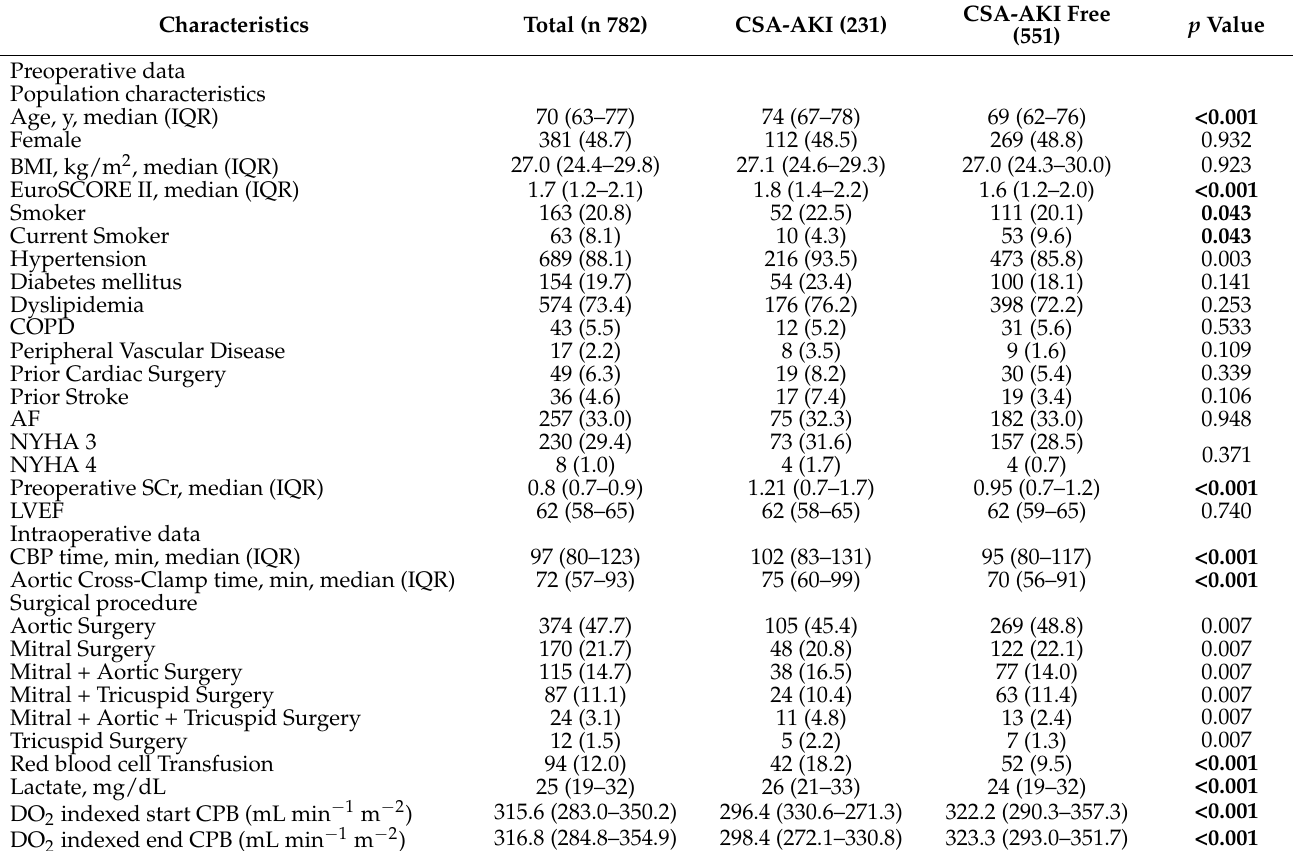
Table 1. Preoperative and intraoperative features based on CSA-AKI presence.